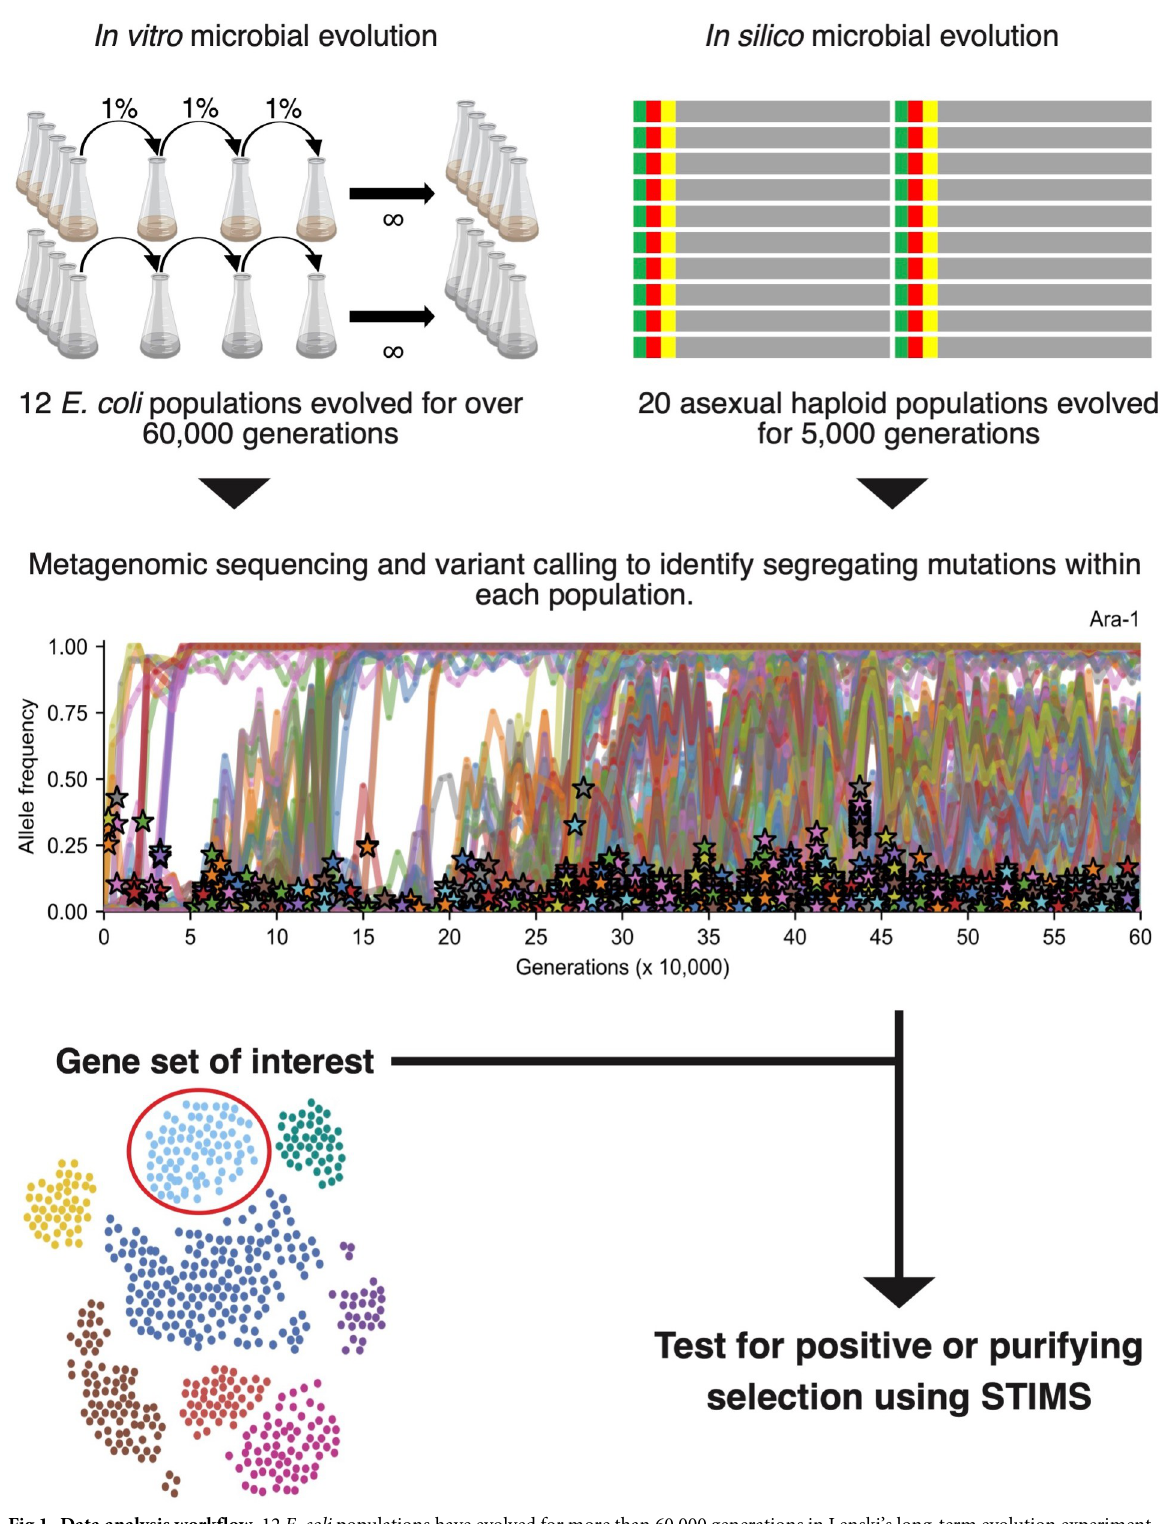
Fig 1. Data analysis workflow. 12 E . coli populations have evolved for more than 60,000 generations in Lenski’s long-term evolution experiment (LTEE). We reanalyzed metagenomic time series of the LTEE, reported by Good and colleagues [16]. We also evolved 20 asexual haploid populations in silico for 5,000 generations. We identified variants segregating during the simulations to model metagenomic sequencing and